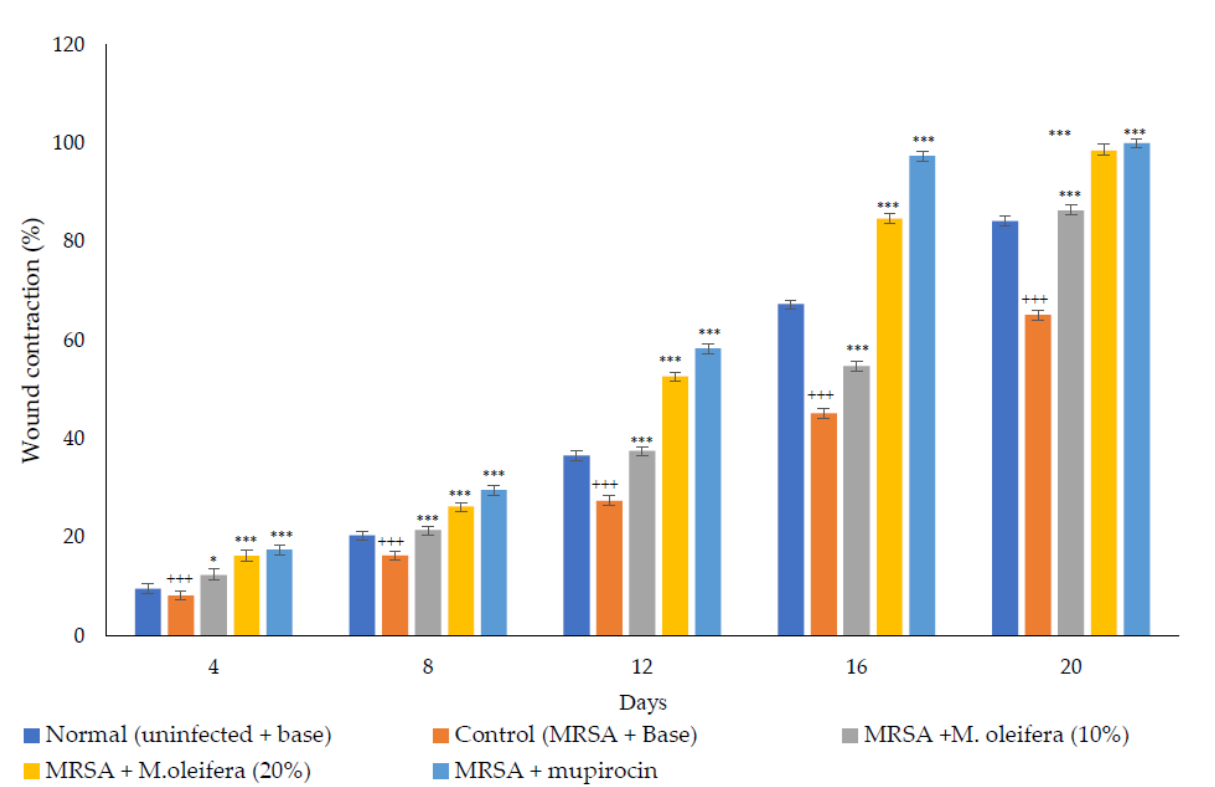
Figure 4. M . oleifera extract ointment preparation on the percentage of wound contraction in MRSA ‐ infected wounds. All values are mean ± SEM, n = 6, * p < 0.05 when compared to control; *** p < 0.001 when compared to control; +++ p < 0.01 when compared to normal.